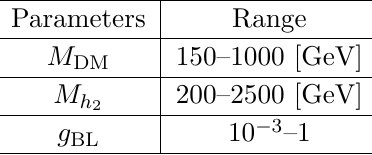
M h ( M DM (cid:27) SI ) plane after satisfying 2 (cid:0) (cid:0) = M N 0 = 361 : 4 GeV, M N = M N 0 = 296 : 2 GeV, 1 2 1 2 = 250 GeV, M Z = 4000 GeV, h e(cid:22) = 1 : 58, h e(cid:28) = 1 : 63, h (cid:22)e = 2 : 38, 3 BL M 1 = M 2 M DM = 50 GeV. (cid:0) (cid:0)